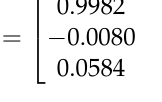
Figure 12. Multigroup reprojection error of the camera.